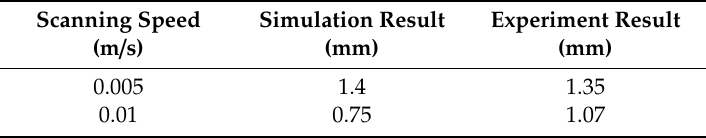
Table 5. The depth of the molten pool provided by the simulation result and the experiment result. Scanning Speed Simulation Result Experiment Result (m/s) (mm) (mm)